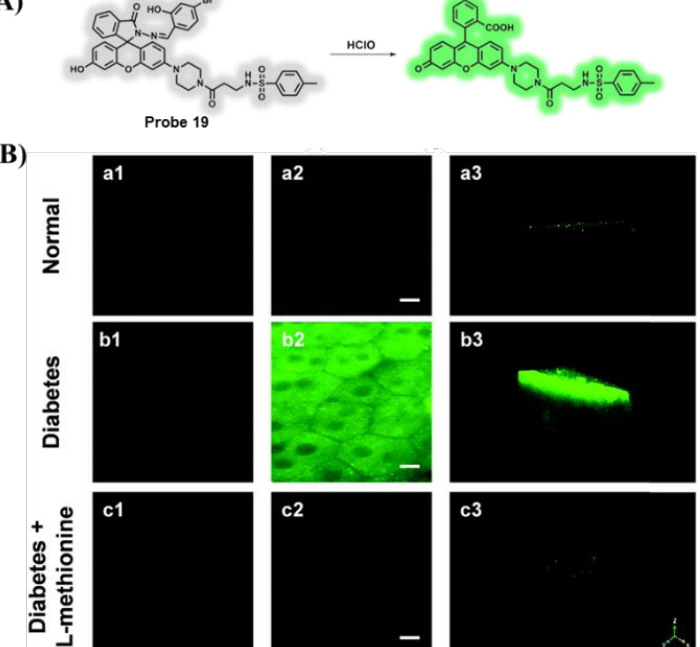
Figure 15. ( A ) Imaging mechanism of probe 19 ; ( B ) the comparison of liver tissue imaging in different groups (i.e., normal mice group, diabetic mice group, and diabetic mice with L-methionine group). ( B - a1 , B - b1 , B - c1 ) control group; ( B - a2 , B - b2 , B - c2 ) imaging of liver tissue after incubation with probe 19 ; ( B - a3 , B - b3 , B - c3 ) 3D imaging of liver tissue after incubation with probe 19 . Scale bar: 25 µ m. Adapted from Reference [95]. Copyright 2021, the Royal Society of Chemistry.